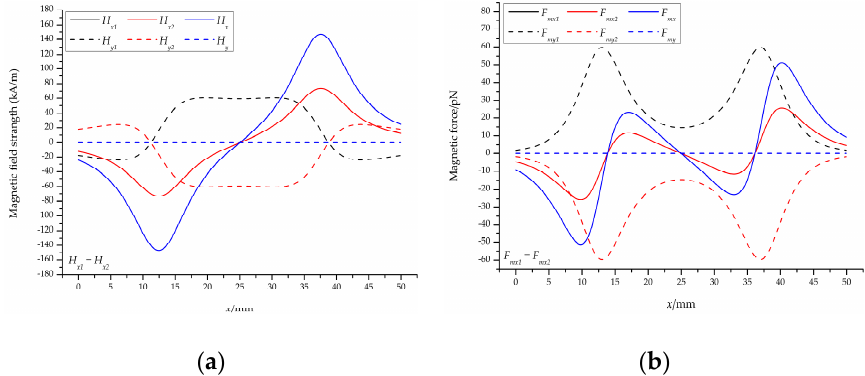
Figure 5. The results of vertical magnetic field: ( a ) The magnetic field strength and ( b ) the magnetic force acting on the particles at the center of the channel. Note that the residual magnetization of a single permanent magnet is 1.2 T.